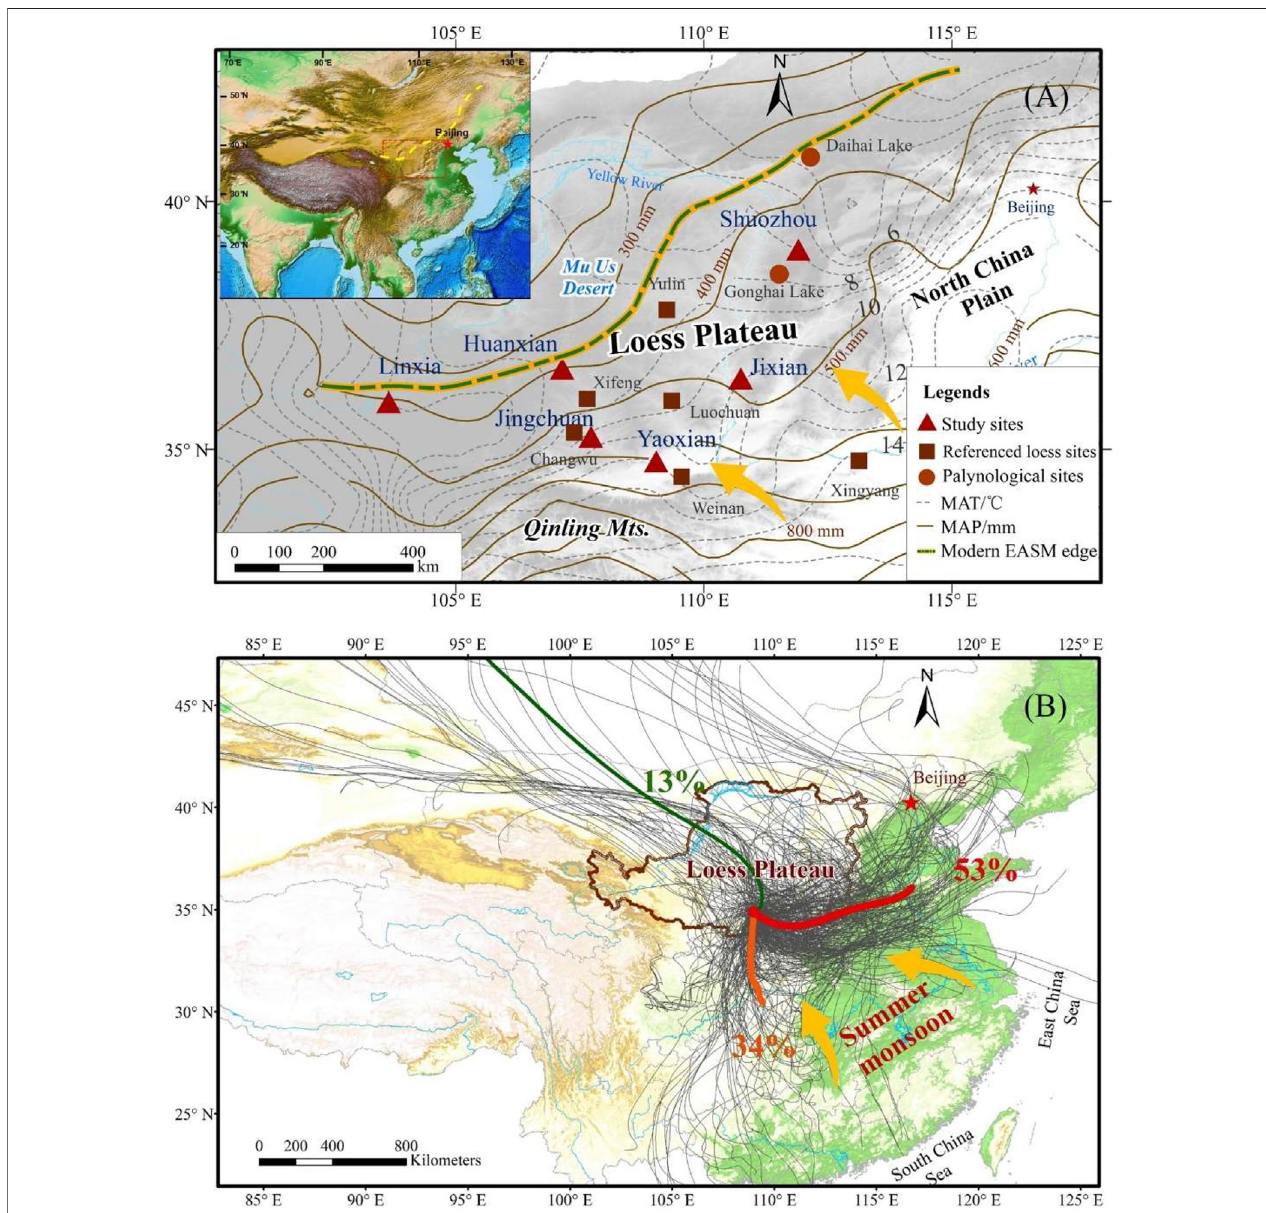
FIGURE 1 | Locations of the studied sections (solid red triangles) along climatic gradients from the northwest to southeast across the Chinese Loess Plateau (A) . The inset map shows the location of the study area and the modern northern edge of the EASM region. The arrows indicate the direction of the summer monsoonal winds. Brown squares and red circles denote locations of the loess sites and palynological sites referenced in the text. The isohyets (in mm; gray lines) and isotherms (in ° C;browndashed lines)are50-yearsaverages(Linet al.,2002). (B) Ensemblesofbackward air-parcel trajectories(Draxler andHess,1997)ofthesourcemoisture for the Yaoxian loess site. Grey lines indicate daily backward (144 h) moisture trajectories of rainfall events ( > 0 mm/day) from January 2005 to December 2011, at the heightof1,000 mabovegroundlevel.ThreeprimarymoisturetransportpathstotheYaoxianloesssiteweregeneratedusingclusteranalysisofmoisturetrajectories.The greenpaths denote the Westerlies; thegreen paths denote theeastern branch oftheEast Asiansummermonsoon;thered path denotessouthernbranchesofthe East Asian summer monsoon. The data for backward trajectories analysis were downloaded from (ftp://arlftp.arlhq.noaa.gov/pub/archives/reanalysis/).